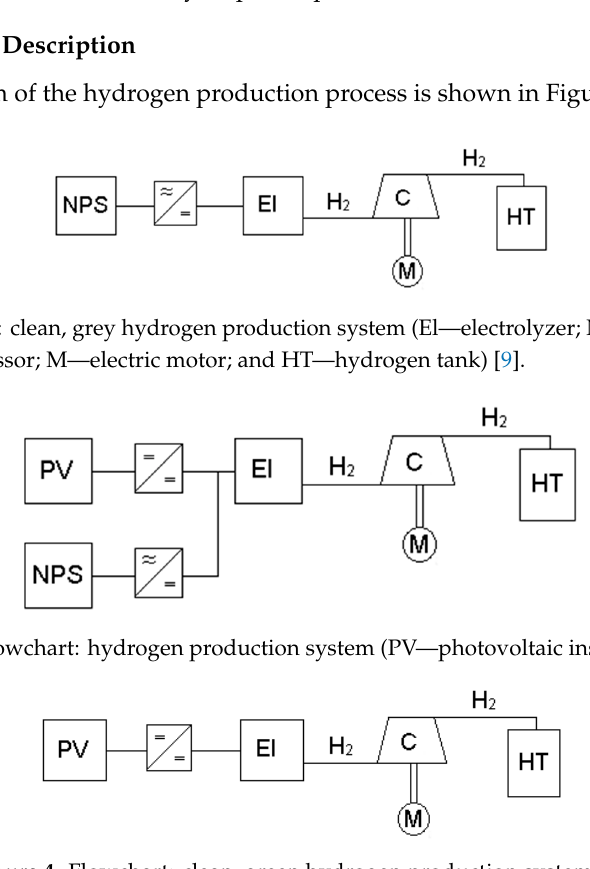
Figure 4. Flowchart: clean, green hydrogen production system [9].